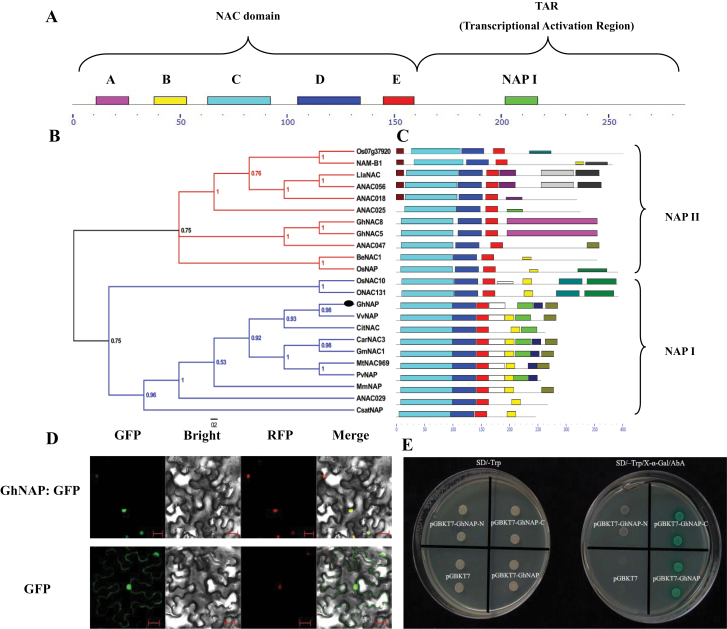
Structural, phylogenetic, subcellular localization, and transcriptional activation analysis of GhNAP. (A) The NAC domain and TAR of GhNAP. Subdomains are shown by rectangles. (B) Phylogenetic analysis of GhNAP. The phylogenetic tree was constructed using the Bayesian method based on the multiple alignments of 23 NAP protein sequences. The tree is unrooted. The numbers in the clades are posterior probability values. (C) Distribution of 15 putative conserved motifs in the NAP subfamily by the MEME search tool. Different motifs are represented by various boxes. The location of each motif can be estimated using the scale at the bottom. The groups within the NAP subfamily are classified by different brackets according to the phylogenetic relationship. (D) Subcellular localization of GhNAP. The GhNAP–GFP fusion protein and free GFP were transiently expressed in transgenic Nicotiana benthamiana plants expressing RFP–H2B, and the transformed leaves were observed by confocal microscopy. Images in the first column show cells with the GFP signal. Images in the second column show the bright-field view of the same cells. Images in the third column show the same cells with the RFP signal, and the images in the fourth column are the overlays of the bright-field and fluorescent images. Scale bar=20 μm. (E) Transcriptional activation analysis of GhNAP in yeast. The full length and the N- (GhNAP-N) and C-terminal (GhNAP-C) regions of GhNAP were inserted into the pGBKT7 vector. The pGBKT7 plasmid was used as the negative control. The above four constructs were transformed into yeast on SD/–Trp and SD/–Trp/X-α-Gal/AbA media for examination of growth. (This figure is available in colour at JXB online.)